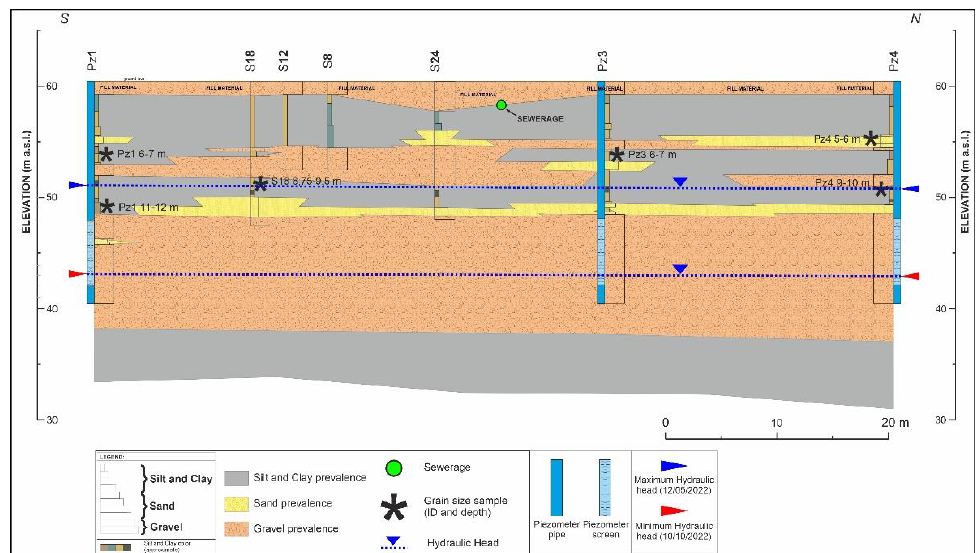
Figure 4. Geological section at site scale (the trace is shown in Figure 3).